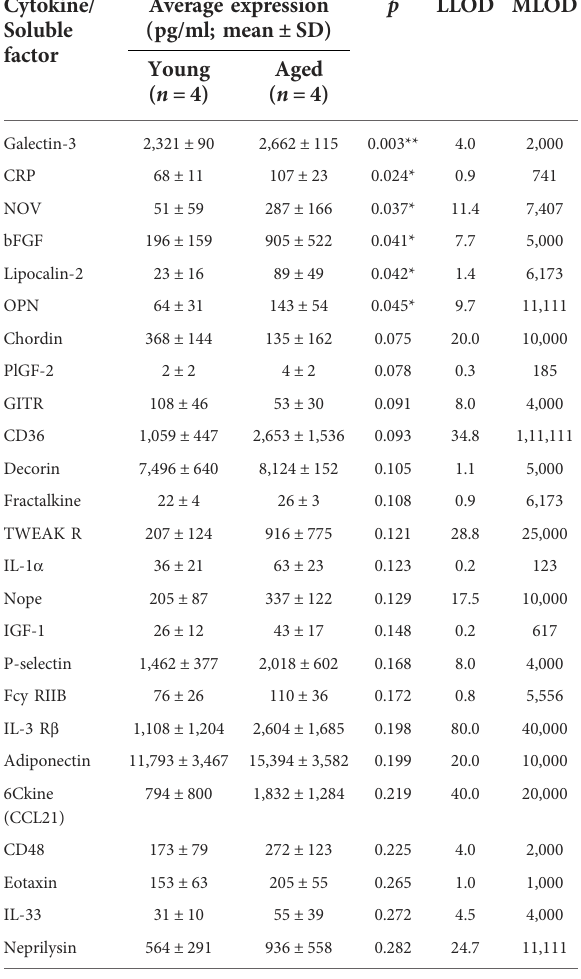
TABLE 1 Top 25 differently expressed cytokines/soluble factors ranked by p value. Cytokine/ Soluble